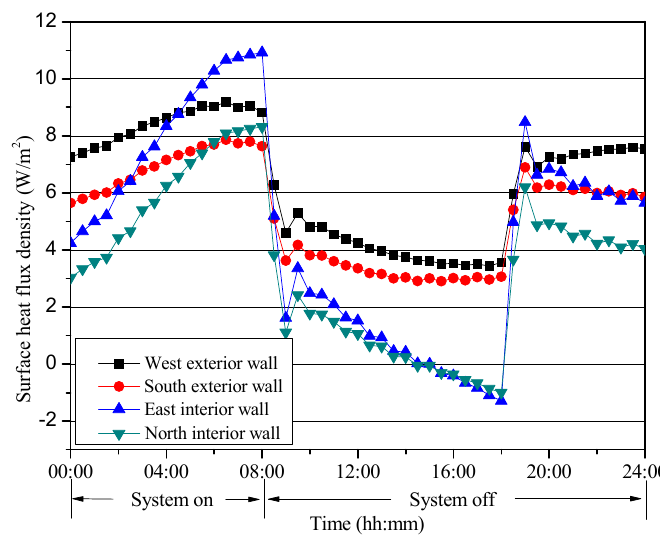
Figure 7. Heat flux density variation trends of passive walls on 10 July.